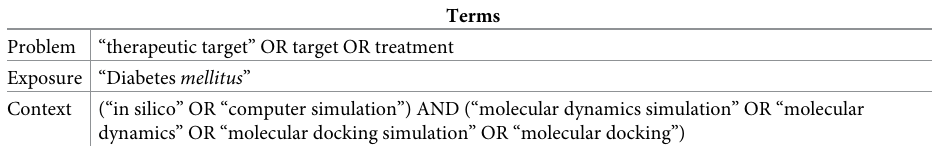
Table 4. Search strategy for the Pubmed database to recover to answer the systematic review’s question: What therapeutic targets have been used in in silico analysis for the treatment of diabetes mellitus